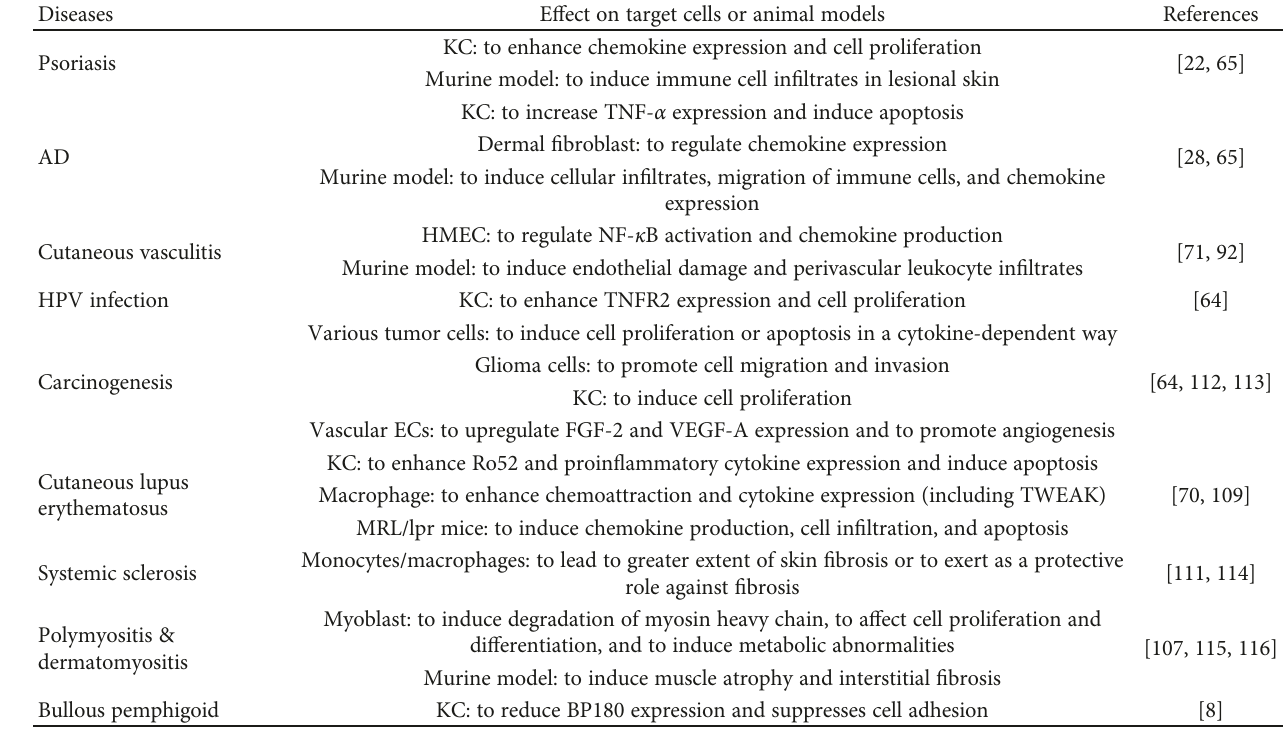
Table 1: The action of TWEAK in di ff erent skin